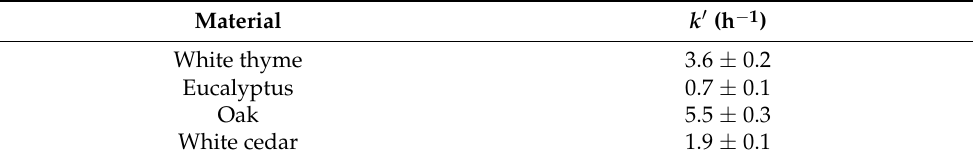
Table 1. Kinetic constants of silver NPs’ growth.